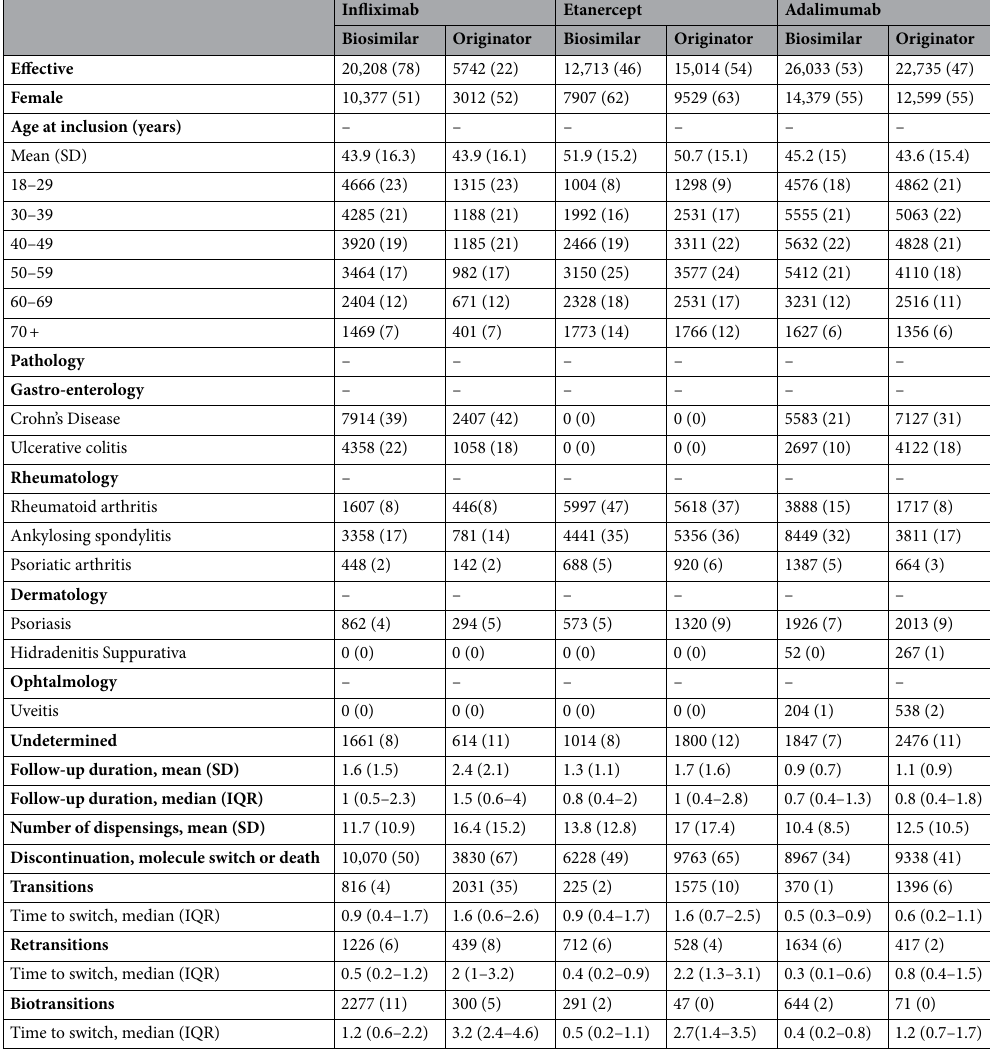
Table 1. Initiators characteristics at inclusion and during the study follow-up, by molecule and product type. Figures are no. (%) unless stated otherwise. IQR, interquartile range; SD, standard